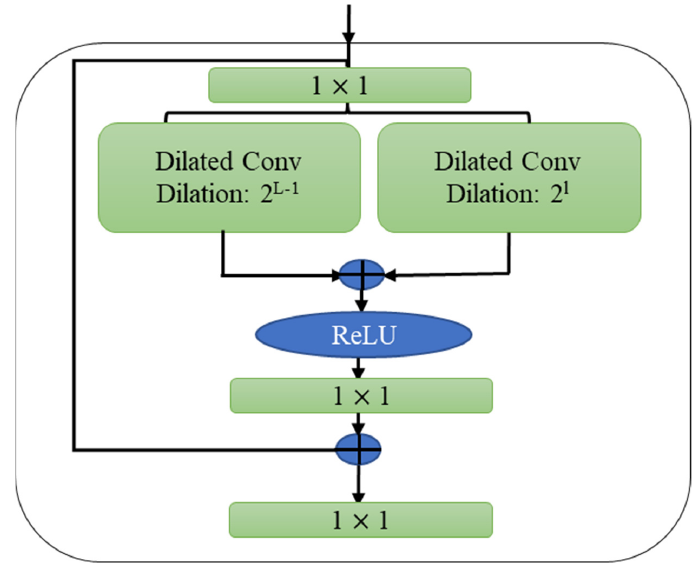
Figure 2. Architecture of dual dilated